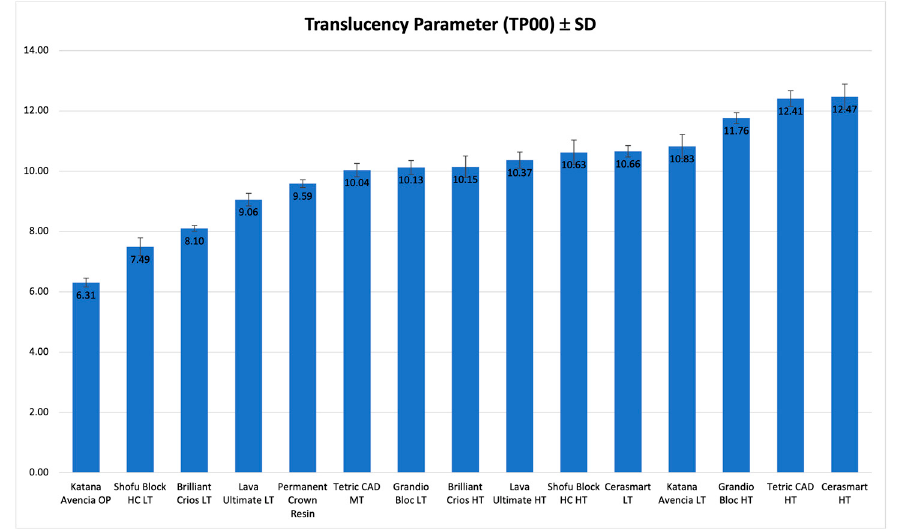
Figure 6. Graphic representation of TP 00 for 1.0 mm of the investigated materials.